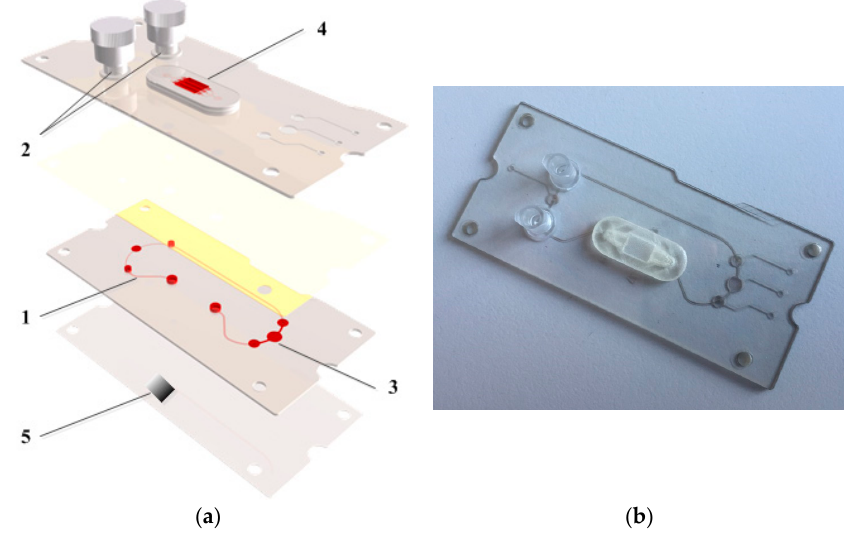
Figure 2. ( a ) Explosion view of the demonstrator system. Closed circulation system: (1) filled with red fluid, consisting of two reservoirs; (2) a three-point-peristaltic-pump; (3) as well as a 3D printed cell culture segment; (4) with integrated chamber and channels. On the bottom is a product protection mark; (5) ( b ) Photograph of the demonstrator.